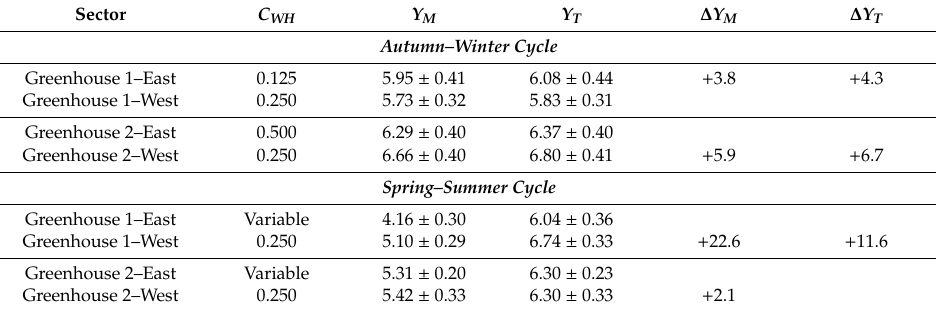
Table 8. Mean ( ± standard deviation) marketable Y M and total yield Y T (kg m − 2 ) of tomato in both for marketable ∆ Y M and total yield ∆ Y T